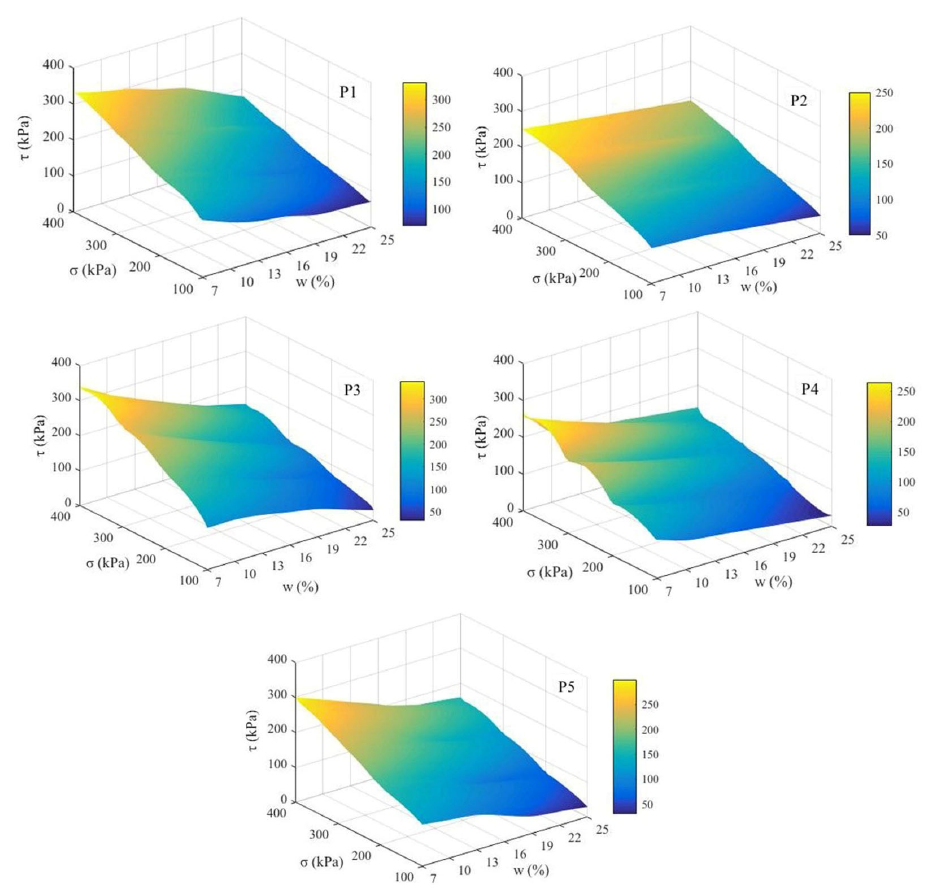
Figure 5. The variation in soil shear strength under different soil water contents and vertical pressures ( τ , σ , and w represent the soil shear strength, vertical pressure, and soil water content, respectively).